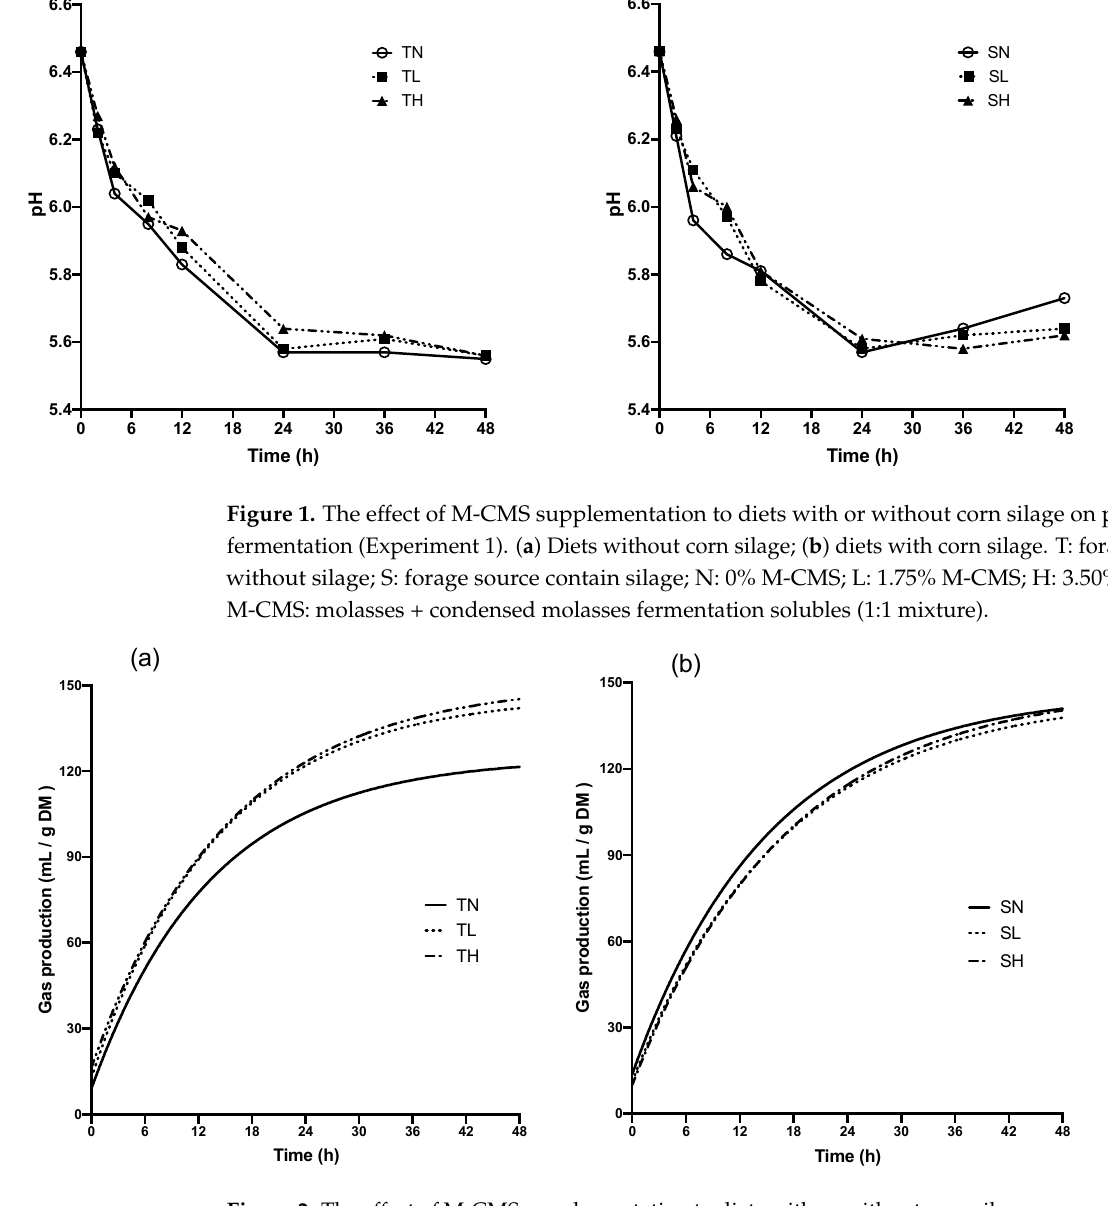
Figure 2. The effect of M-CMS supplementation to diets with or without corn silage on gas production (Experiment 1). ( a ) Diets without corn silage; ( b ) diets with corn silage. T: forage source without silage; S: forage source contain silage; N: 0% M-CMS; L: 1.75% M-CMS; H: 3.50% M-CMS; M-CMS: molasses + condensed molasses fermentation solubles (1:1